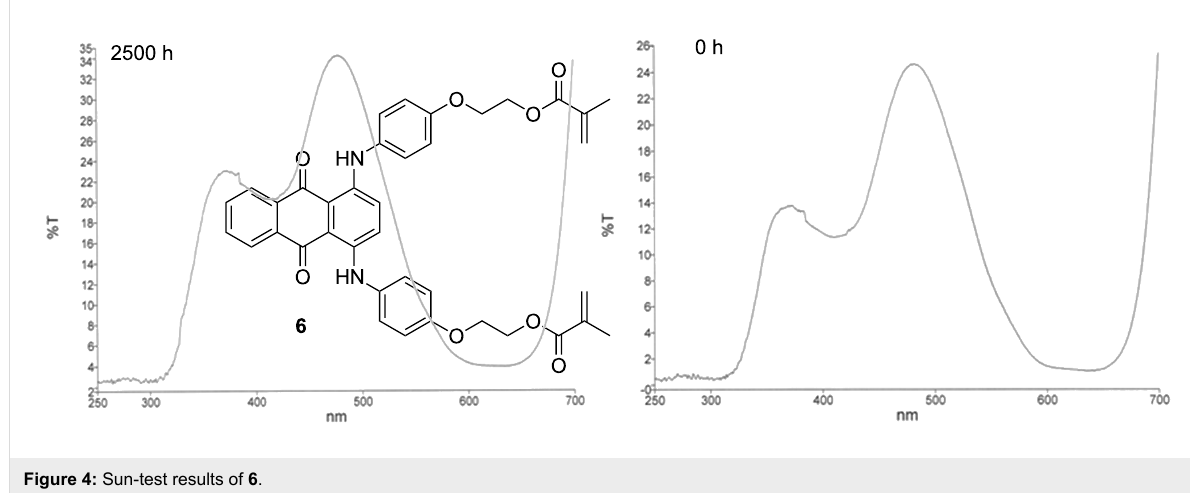
For use in medical applications like iris implants, the dyes and the corresponding polymers have to be biocompatible (ISO 11979-5) [33-35]. To analyze the photosensitivity of the ma- terials, the dye-containing polymers were preserved in a sodium chloride solution at 35 °C and exposed to irradiation with visible light (3 mW/cm 2 2500 h) for 100 days. As an example, Figure 4 shows the transmission spectrum for the